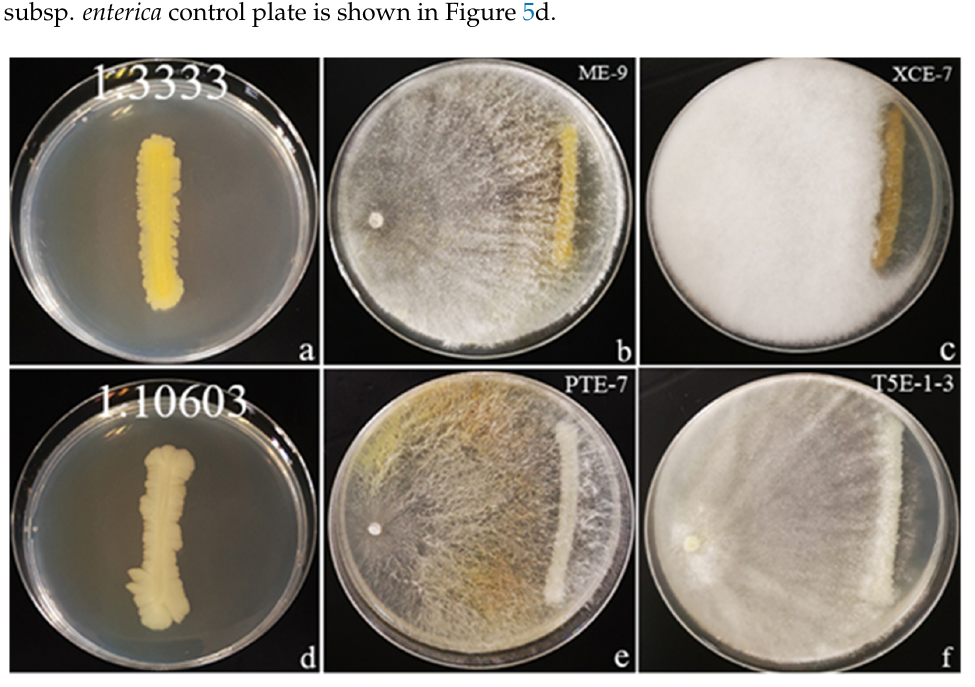
Figure 5. Illustration of an antagonist test by the dual-culture technique with two bacterial patho- gens and an inhibition rate greater than or equal to 60%. The two pathogens were cocultivated with the coffee fungal endophytes on NA plates and incubated for 10 days at 28 °C. ( a ) Pseudomonas syringae control plate; ( b , c ) Coffee endophytes inhibit Pse. syringae ; ( d ) Salmonella enterica subsp. en- terica control plate; ( e , f ) Coffee endophytes inhibit S. enterica subsp . enterica